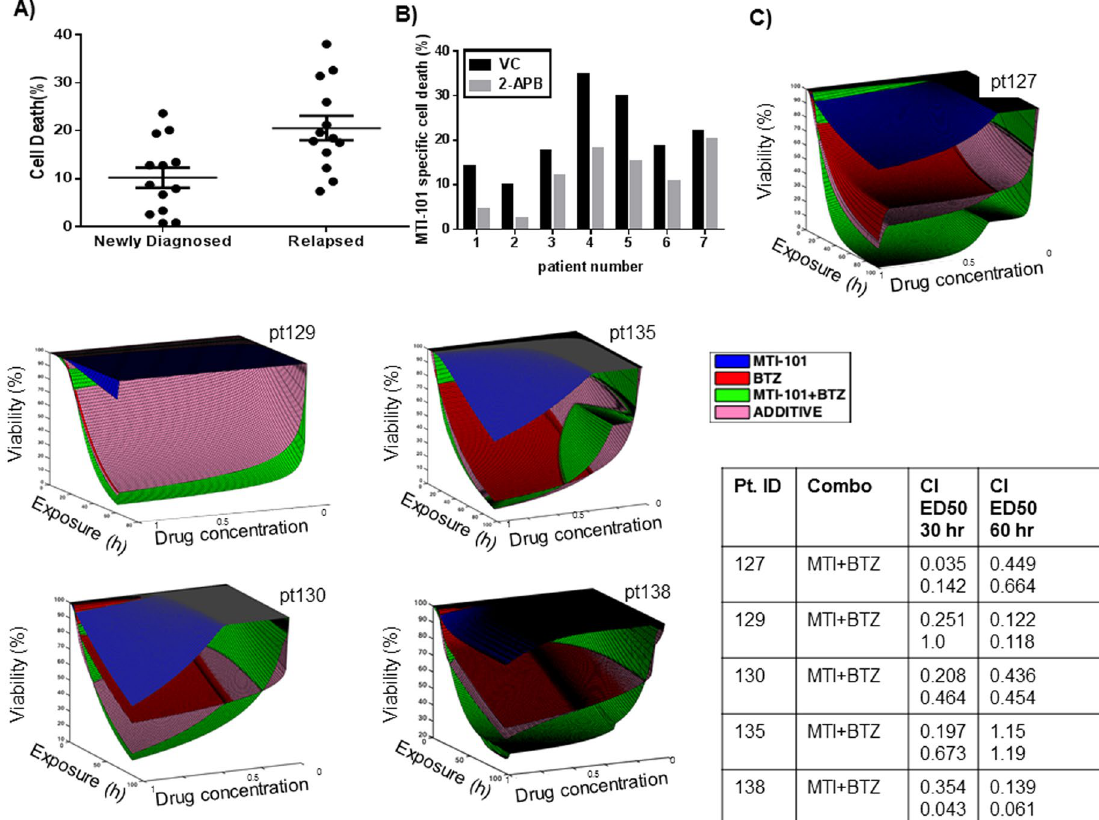
Figure 6. Relapsed myelomas are more sensitive to MTI-101. Specimens were separated into two groups depending on clinical diagnosis; either newly diagnosed or relapsed patients. ( A ) CD138 + cells were treated with 10 µ M of MTI-101 for 24 hr. After 24 hr cell death was measured by Annexin V staining and FACS analysis. CD138 cells derived from patients which have relapsed on therapy were significantly more sensitive to MTI- 101 induced cell death compared to CD138 cells obtained from newly diagnosed patients (p < 0.05, Student’s t-test) ( B ) CD138 + cells were pretreated with 50 µ M 2APB or VC (vehicle control) for 30 min and then were treated with 10 µ M MTI-101 for 24 hrs followed by FACS analysis. ( C ) Dose response surfaces for primary MM cells from patients treated ex vivo with bortezomib (50–0.6 nM, 3 fold serial dilution), MTI-101 (20–0.25 uM, 3 fold serial dilultions)) and combination. Exposure time was 96 hrs except for patient pt129 (60 hrs). The actual combination of MTI-101 and bortezomib (MTI-101 + BTZ) is more effective (higher kill) than theoretical additive effect (ADDITIVE) indicating synergy between two drugs. Combination indexes (CI) were calculated using CalcuSyn software at 30 and 60 hrs. Samples were performed in duplicate and independent combination indexes were calculated for each patient